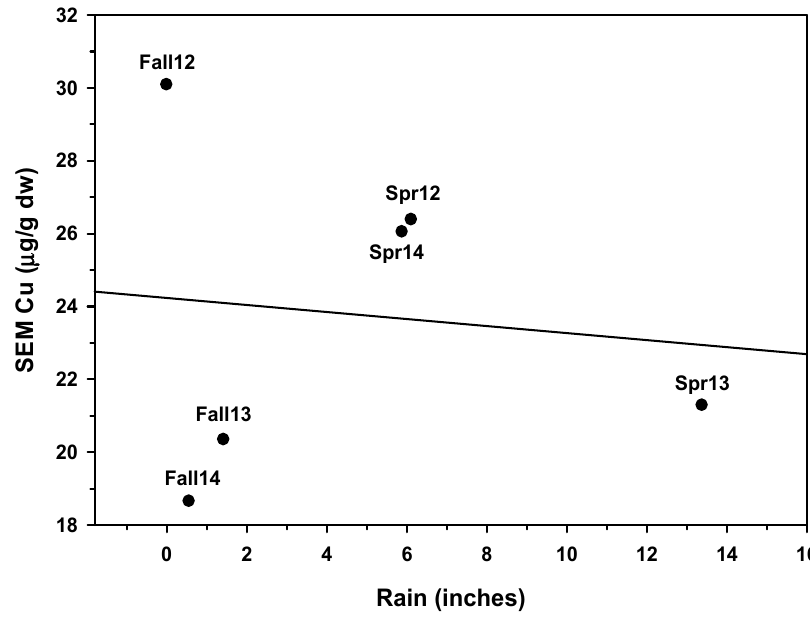
Figure 28. Linear regression results of the total rain in inches at NWS site SACRAMENTO 5 ESE from two different seasons during the water years 2012–2014 versus the mean SEM Cu sediment concentration from all Cache Slough sample sites during the same years (r 2 = 0.012, p = 0.833).